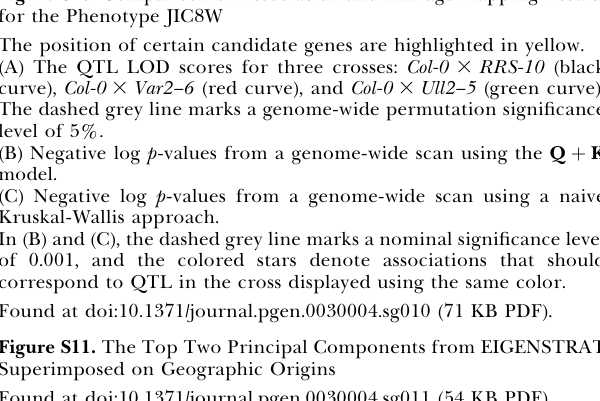
Figure S2. Cumulative Distribution of p -Values from Haplotype- Based Tests Figure S3. Power Comparison for Haplotype-Based Tests Figure S4. Genome-Wide Association Scans Using the K* Model Peak heights represent negative log p -values from tests of association between genotype and phenotype. The dashed grey line marks a nominal significance level of 0.1%. The position of the candidate genes are highlighted. Nominally significant associations occur throughout the genome, and often correlated across phenotypes. Figure S5. Genome-Wide Association Scans Using the Q þ K Model Figure S6. Genome-Wide Association Scans Using the Q þ K* Model Figure S7. Genome-Wide Association Scans Using the P þ K Model Figure S8. Genome-Wide Association Scans Using the P þ K* Model Figure S9. Comparison of Association and Linkage Mapping Results for the Phenotype JIC0W The position of certain candidate genes are highlighted in yellow. (A) The QTL LOD scores for the cross Col-0 3 Kno-18 (blue curve). The dashed grey line marks a genome-wide permutation significance level of 5%. (B ) Negative log p -values from a genome-wide scan using the Q þ K model. (C) Negative log p -values from a genome-wide scan using a naive Kruskal-Wallis approach. (B and C) The dashed grey line marks a nominal significance level of 0.1%, and the colored stars denote associations that should correspond to QTL in the cross.